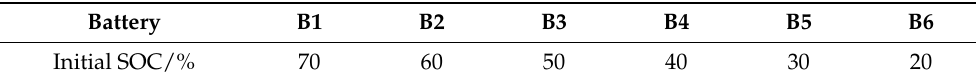
Table 3. Initial SOC of battery.